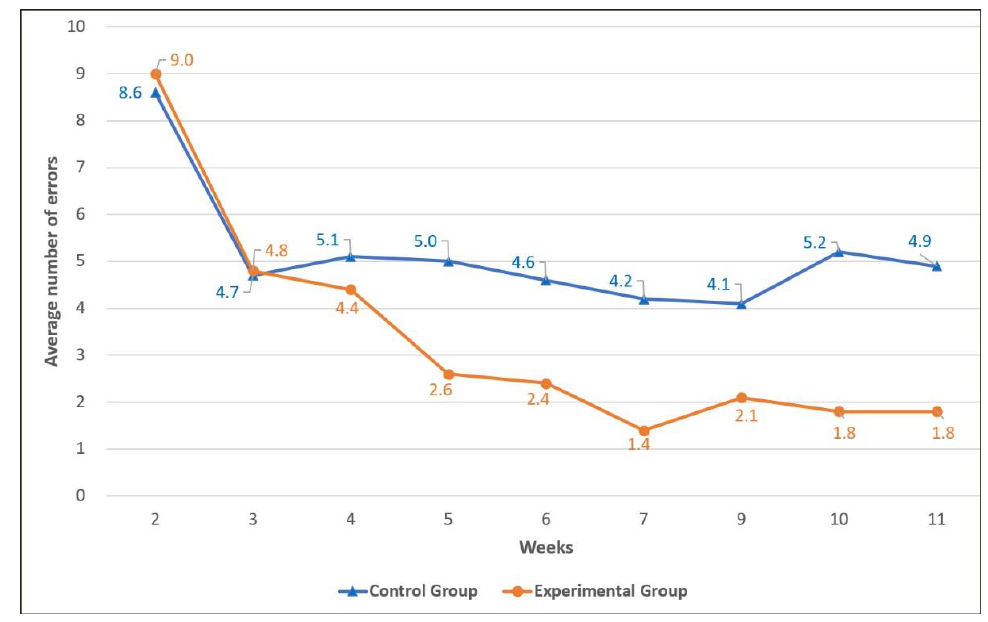
Figure 7. Comparison between two groups in average number of errors.